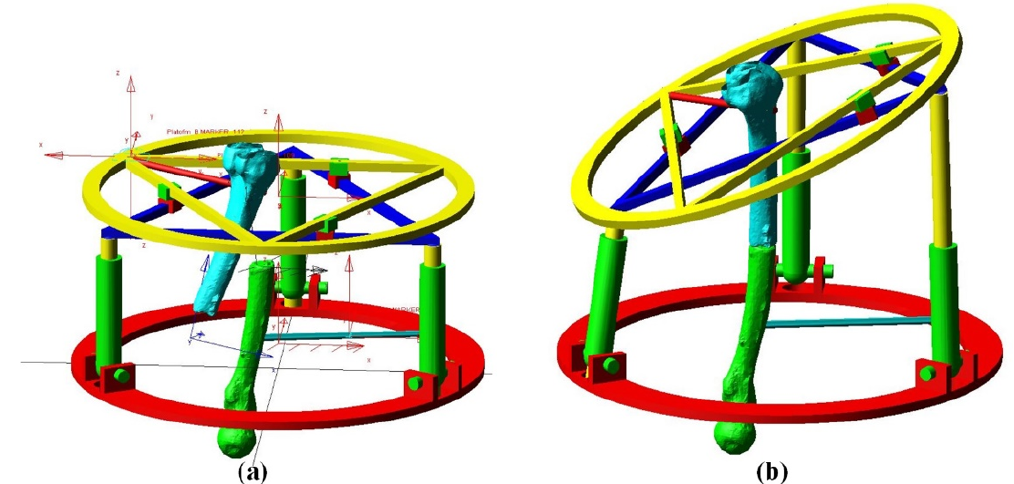
Figure 12. Adams simulation of a bone reduction case using the hybrid mechanism.